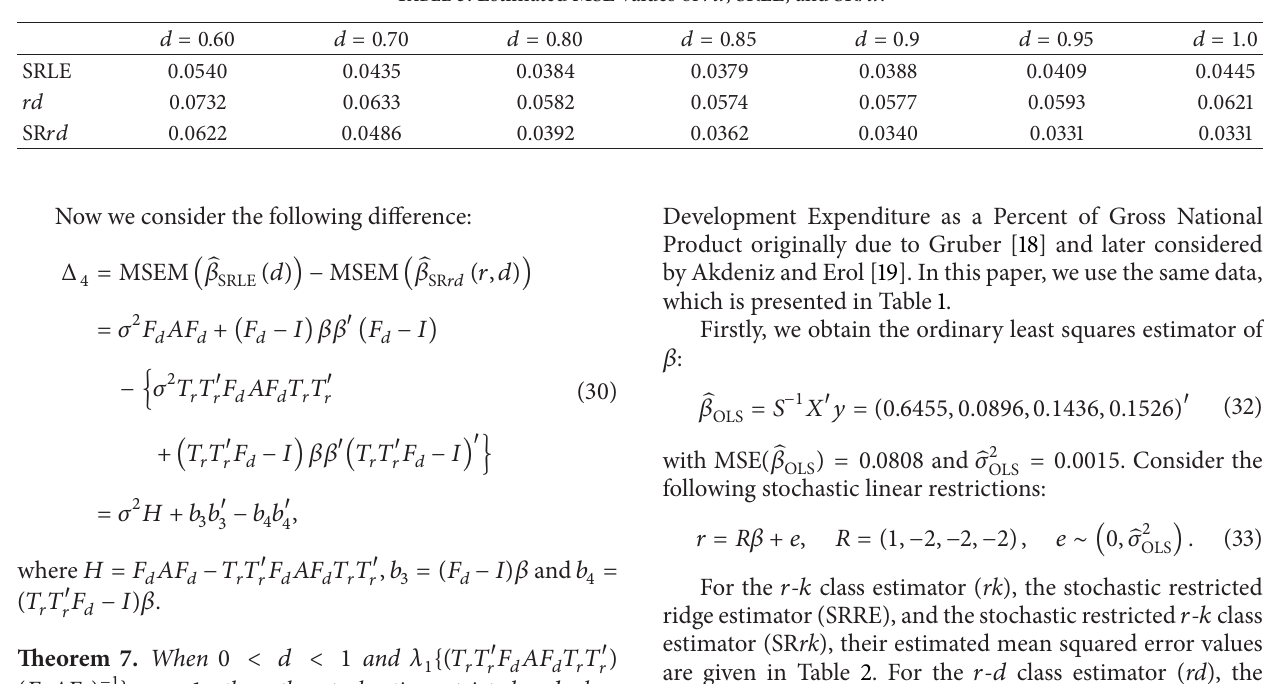
Table 3: Estimated MSE values of 𝑟𝑑 , SRLE, and SR 𝑟𝑑